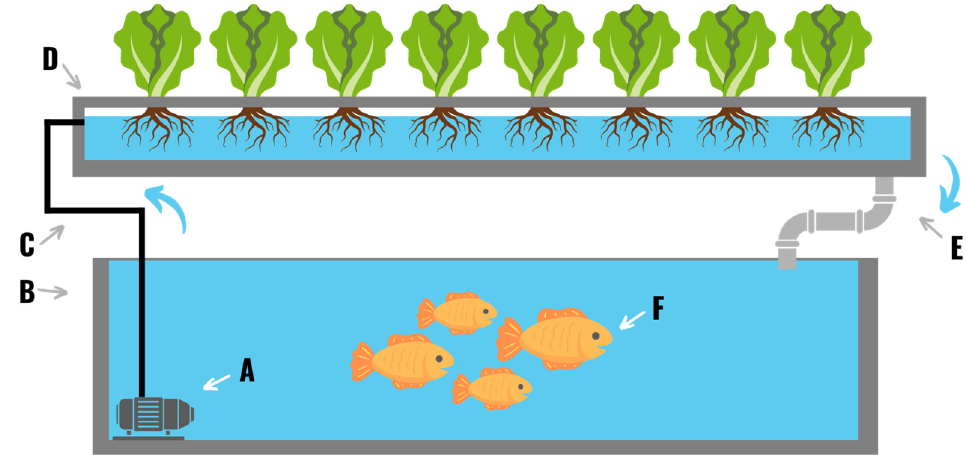
Figure 9. An Aquaponics system composed of a pump ( A ), fish tank ( B ), watering line ( C ), NFT troughs ( D ), water collection pipe ( E ), and fish ( F ). Fish and microbes in the fish tank generate effluent which is used as a nutrient source for the plants. The effluent water is pumped over the roots of the plants, which clean the water by removing metabolic byproducts that are toxic to the fish. The cleaned water is then returned to the fish tank.